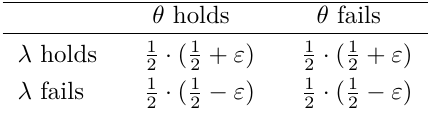
Table 21: The Distribution of the Four Possible Events, in Case θ and λ Are Independent θ holds